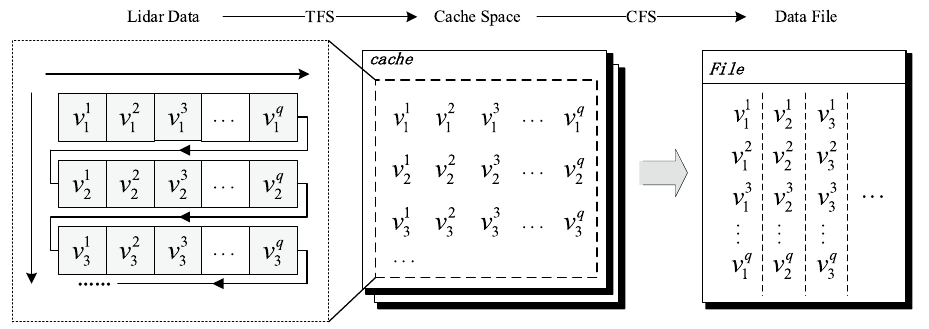
Figure 7. The process of conversion and storage of